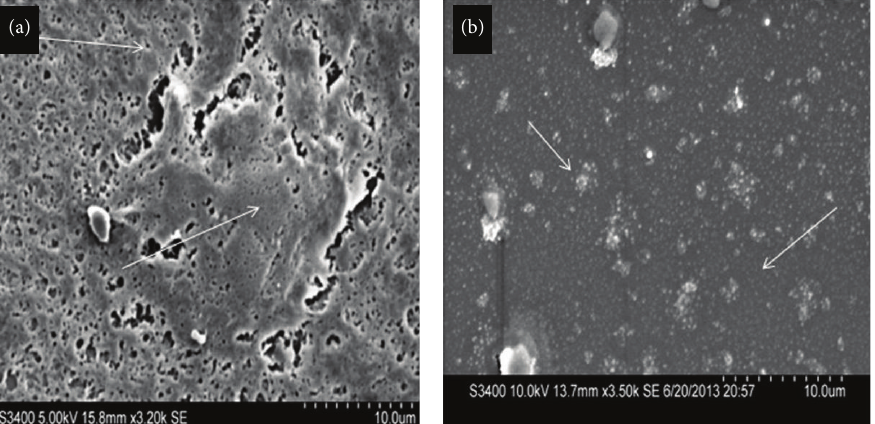
Figure 3: Morphological characterization of native ACM and spin coated ACM. SEM images depicting (a) presence of thick, bulky structures on native ACM and (b) uniform layer of matrix with the presence of subnanosized globular structures on spin coated ACM (scale bar: 10 𝜇